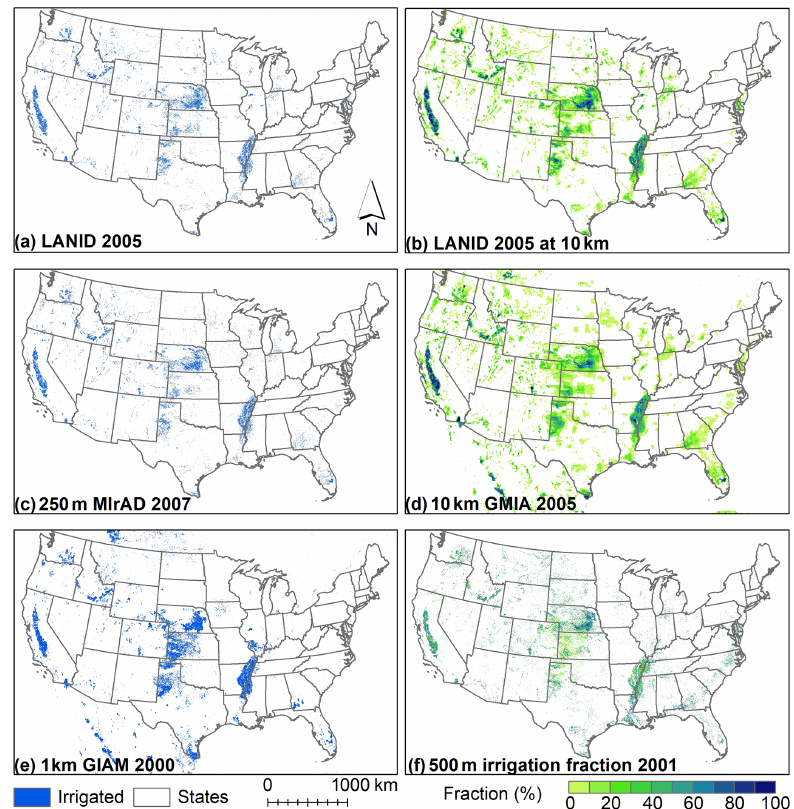
Figure 10. Nationwide views of different irrigation mapping products. LANID 2005 is aggregated to 1 (a) and 10km (d) resolution for comparison purposes. The LANID-derived irrigation frequency refers to the number of years a pixel is classified as